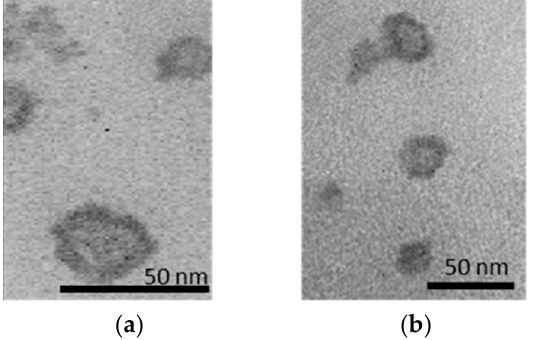
Figure 2. Transmission electron microscopy (TEM) images of ( a ) unloaded SLN and ( b ) unloaded NLC containing tocopheryl acetate 1% w / w .